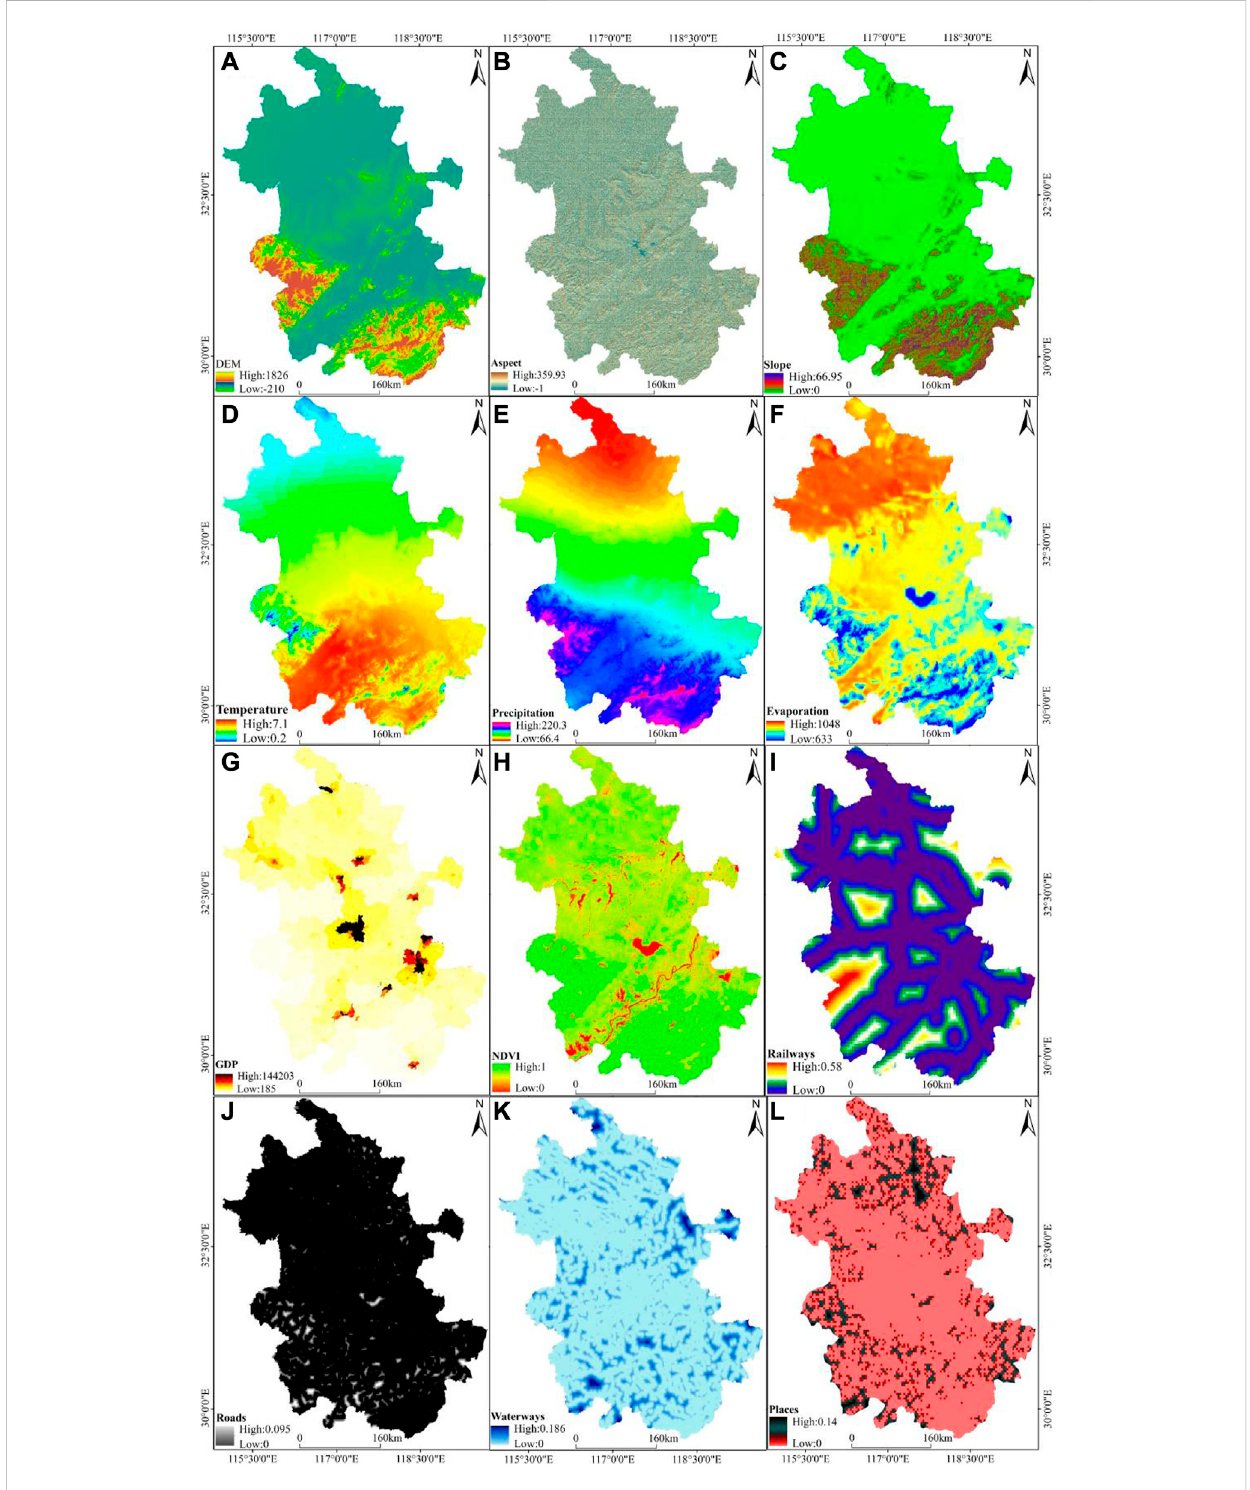
FIGURE 3 Land use simulation drivers. (A) DEM, (B) Aspect, (C) Slope, (D) Temperature, (E) Precipitation, (F) Evaporation, (G) GDP, (H) NDVI, (I) Railways, (J) Roads, (K) Waterways, (L)